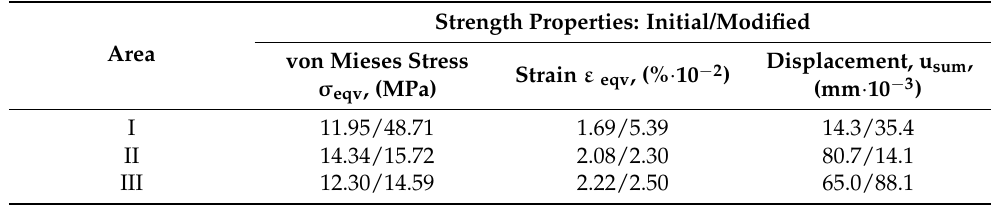
Table 1. Comparative results of strength characteristics of the original and modified structure. Strength Properties: Area